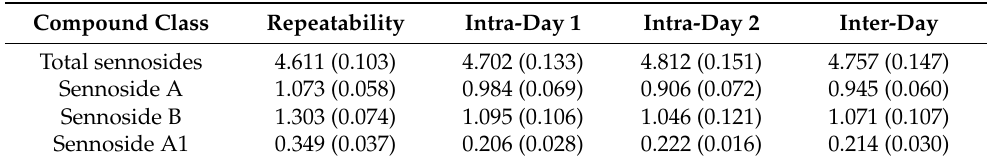
Table 2. Repeatability, intra-day, and inter-day precision of the total sennoside content (calculated as sennoside B) and sennosides A, B, and A 1 . Results are given in % weight of dried plant material; standard deviation is indicated in